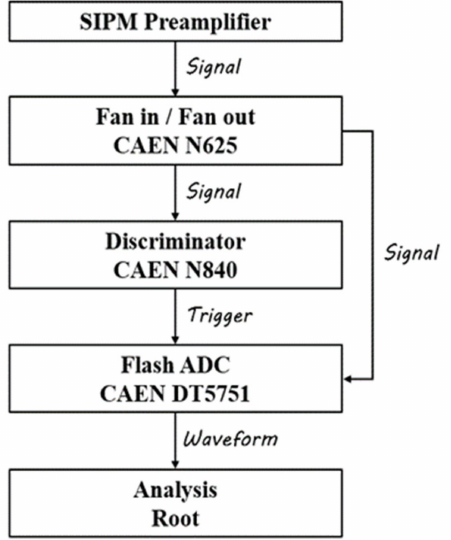
Figure 3. The dark noise measurement